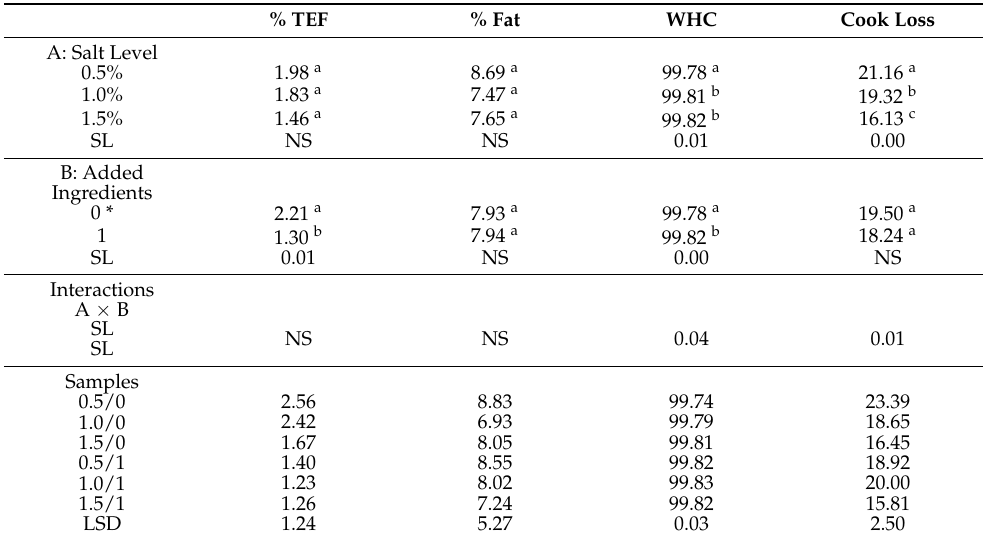
Table 3. The effect of salt levels and added ingredients KCl \ TS on the emulsion stability, water holding capacity and cook loss of breakfast sausages manufactured with pork belly meat high pressure treated at 150 MPa. %